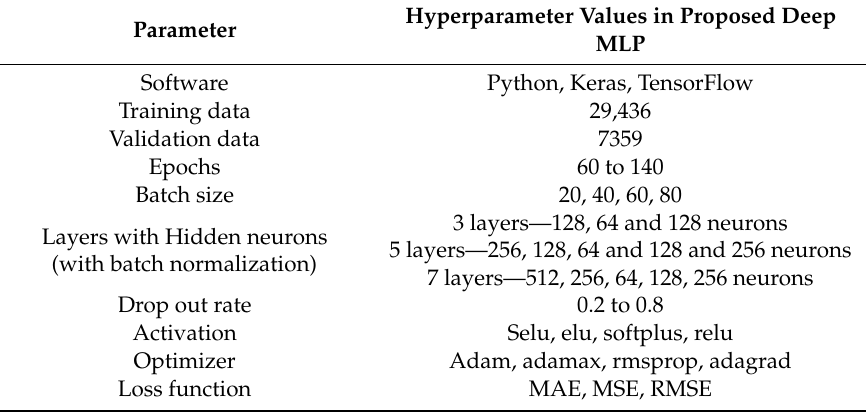
Table 1. The experimental model with the hyperparameter